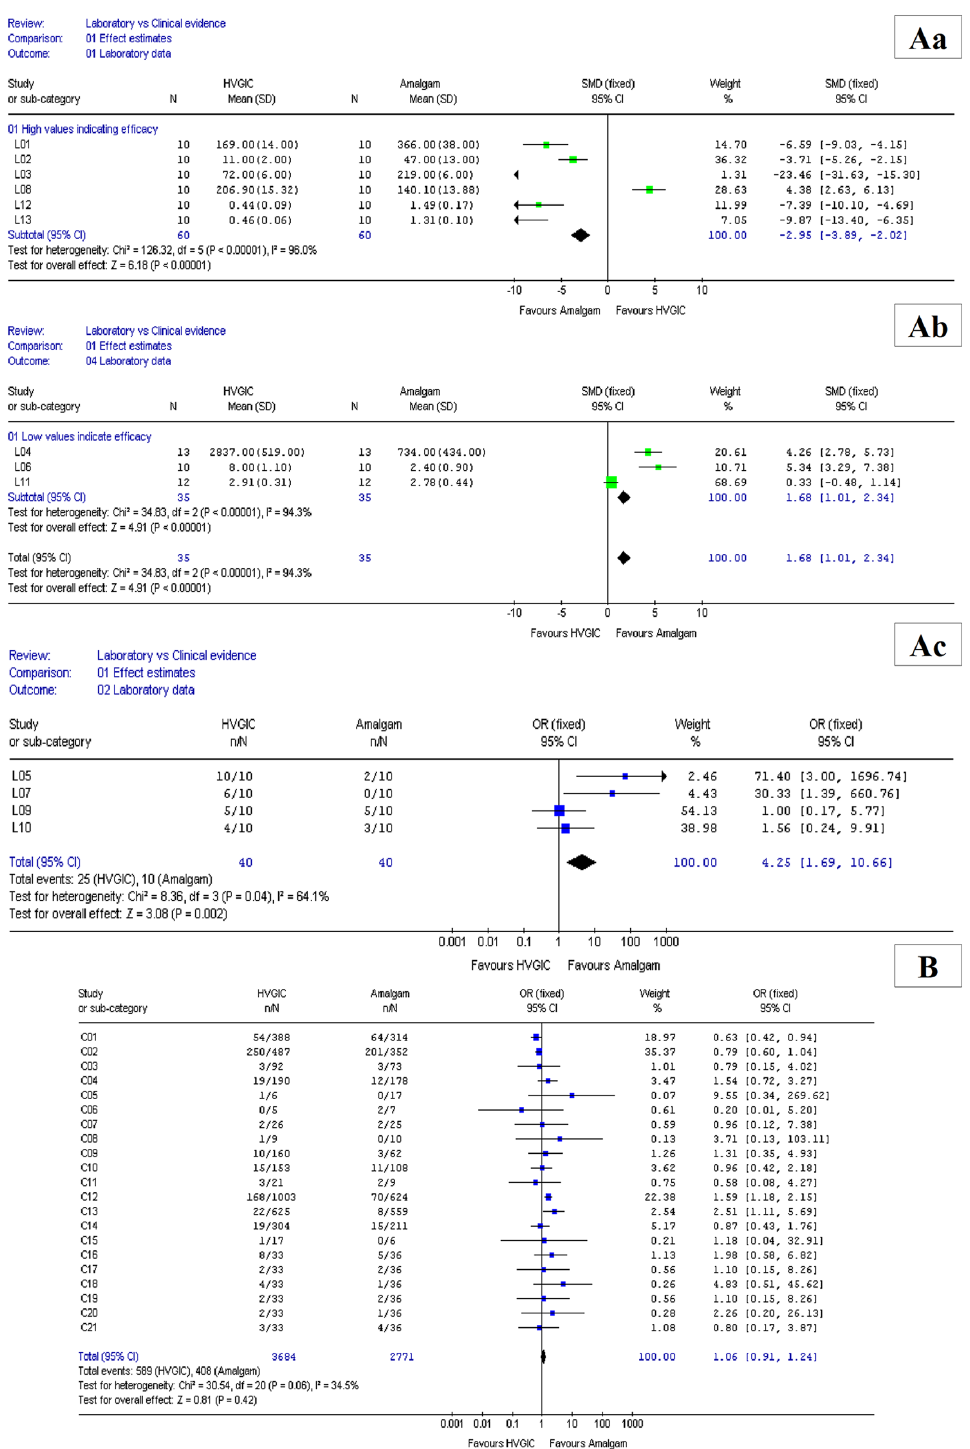
Fig 2. Meta-analysis results. Aa = Laboratory results, continuous data / measured lower values indicate material efficacy; Ab = Laboratory results, continuous data / measured higher values indicate material efficacy; Ac = Laboratory results, dichotomous data; B = Clinical results, dichotomous data.